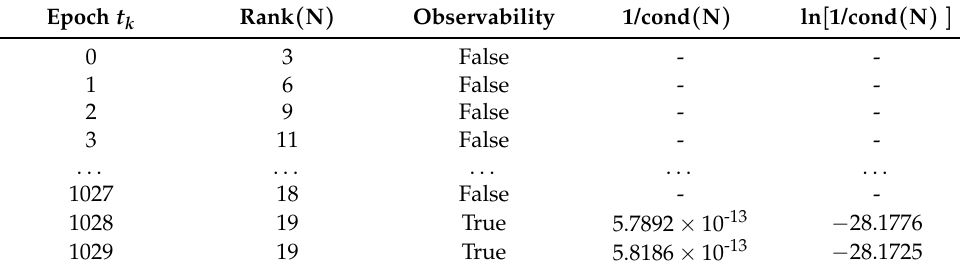
Table 6. Observability test results of case